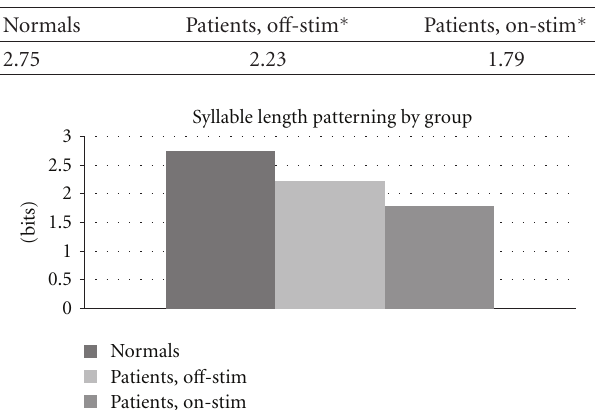
Table 4: Syllable length patterning (bits) by group. ( ∗ = di ff erence from normal significant at P < . 002).